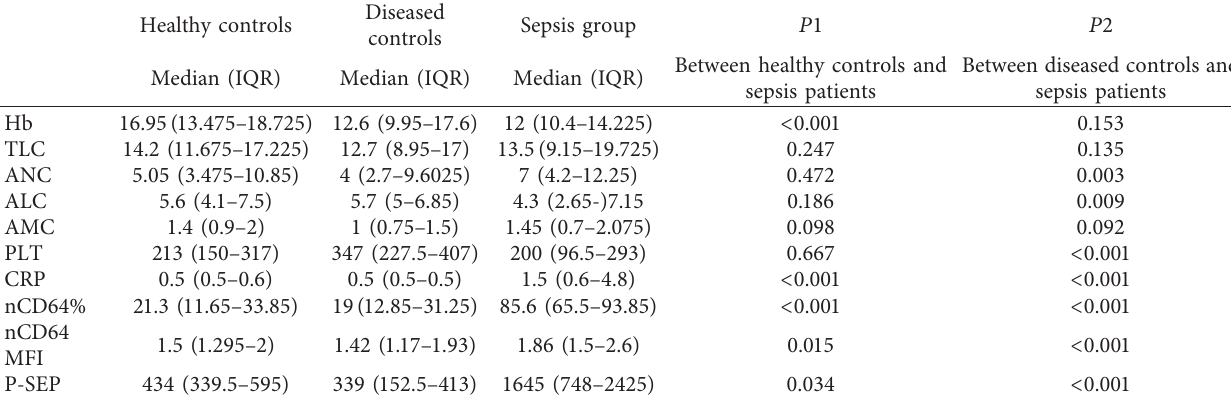
Table 2: Comparative statistical analysis between sepsis and each of the control groups.